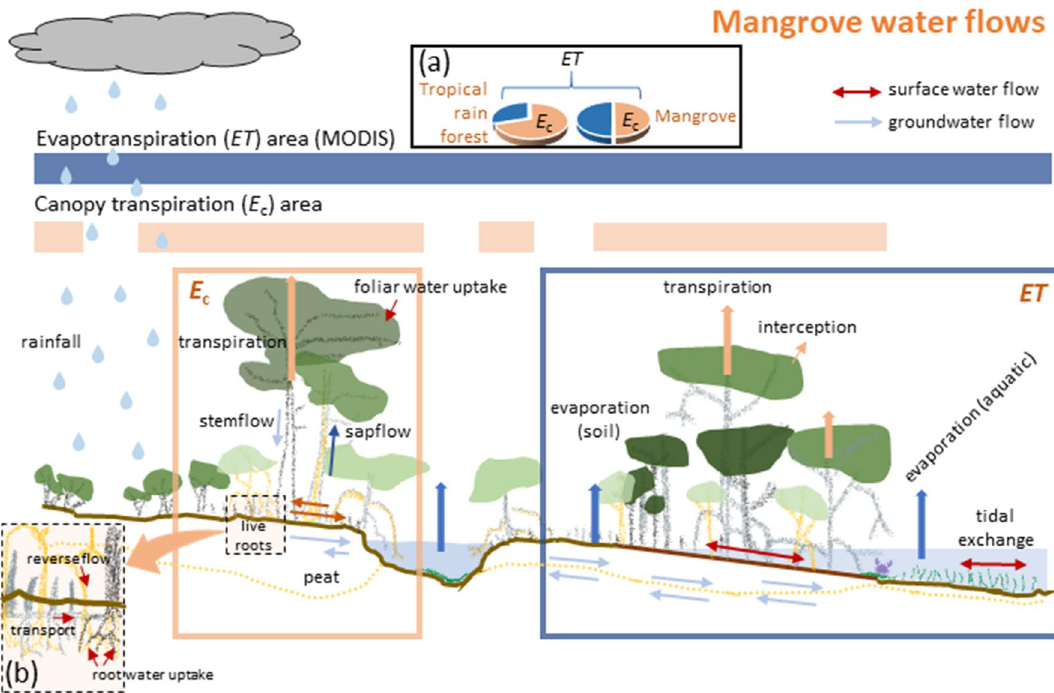
Figure 4. Water flows in mangrove forests associated with either evapotranspiration ( ET ) or canopy transpiration ( E c ), and how areas from MODIS-derived ET data and E c data would relate for mangroves, as well as generally from the literature for other ecosystems. ( a ) Inset represents a comparison of E c -to- ET ratio for mangroves versus tropical rain forests, where most of the world’s mangroves associate. ( b ) Inset represents known water fluxes in mangrove root zones that contribute to E c , and ultimately to ET considered water use for mangroves compared to non-mangrove ecoregions using E c -to- ET ratios to better control for different, but inherent, ET water fluxes from non-transpirational sources. At least four assumptions apply to this E c -to- ET ratio analysis. First, NPP data from each mangrove wetland location, and thus E c approximations, are from the study plots used in the cited studies, and therefore, may not represent the average regional structure of the entire mangrove forest over 1 km 2 . We assume that plots are representative of the larger stand. Second, our approximations of E c focus just on the dominant vegetation and do not include evaporation from flooded soil, saturated soil, tidal creeks, and leaf-intercepted water, or the tide-energy influences on water losses, which would be part of what ET would include 49 . Third, our sap flow generated determinations of E c may exclude some components of the understory. However, the degree to which source-study NPP measurements included saplings and small trees of the understory would influence our esti- mates of E c ; the more inclusive of those understory NPP components from the original data sources, the better our E c approximations. Finally, for the salinity component specific to mangroves, while freshening of water has the potential to increase E c -to- ET ratios, we assume that ET across larger spatial scales is altered only modestly with salinity reduction. To our knowledge, salinity-to- ET relationships have not been assessed at relevant scales to consider further. Empirical assessment of E c -to- ET ratios is limited to only a few mangrove studies. On sites in Southwest Florida, USA with moderate stand basal areas (23–28 m 2 ha −1 ) and average canopy heights (10–11 m), regional ET was 1029–1048 mm H versus an ET rate of 1378 mm year −1 (or 63% of ET ) in an Everglades mangrove stand, also in south Florida, but in a location were the stand had moderate salinity concentrations (~ 25 psu), greater basal area (41 m 2 ha −1 ), and taller trees (19 m) 50 . E c -to- ET ratios ranged from 30 to 66% among three additional mangrove sites in China, with these ratios linked to seasonal leaf area index and salinity change 52 . Unlike the direct linear increases in WUE int described at the leaf-level as salinity increased (Fig. S1) 20 , mangrove E c remained fairly constant over salinities of ~ 10 to 28 psu and decreased beyond 52 . Thus, empirical estimations of E c -to- ET ratios fall within the range of our derived values. In fact, any discrepancies trended toward more water-use conservative E c -to- ET ratios for mangrove vegetation. By aligning global mangrove area with the distribution of adjacent ecoregions to mangroves, water use dif- (Table 1, Table S1). We add this perspective to demonstrate that having mangroves along a coast can indeed be consequential to water cycling locally as well as globally. Even under an assumption of low soil porewater salinity, consumptive water use by mangroves is still comparatively low (by 16.2 TL H 2 O year −1 ). Likewise, our predictive variable (NPP) for approximating E c among the world’s mangroves is linked strongly to rainfall, explaining up to